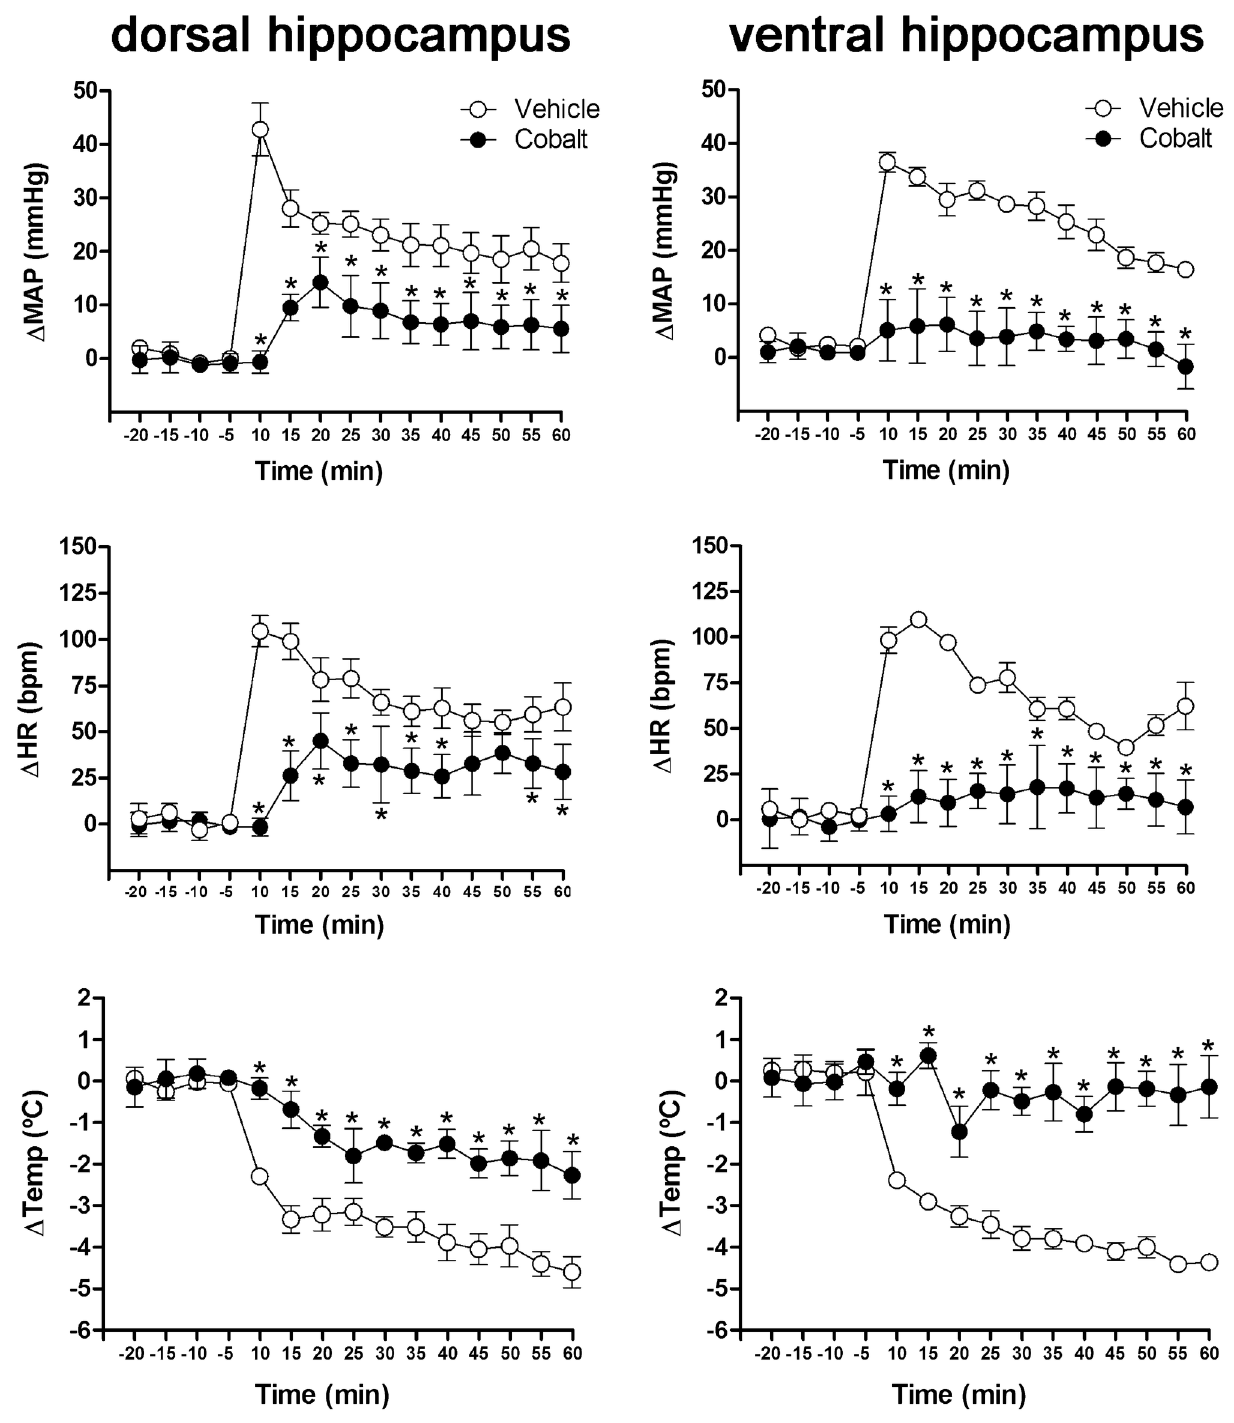
Figure 2. Time-course of bilateral microinjection of 200 nL of vehicle (n=6/ DH and VH) or 1 mM of CoCl and VH) administered into DH or VH on changes in mean arterial pressure (∆MAP), heart rate (∆HR) and cutaneous temperature (∆Temp) of animals submitted to 60 min of restraint stress. Symbols represent the means and bars the SEM. *P<0.05, Bonferroni’s post-hoc test.